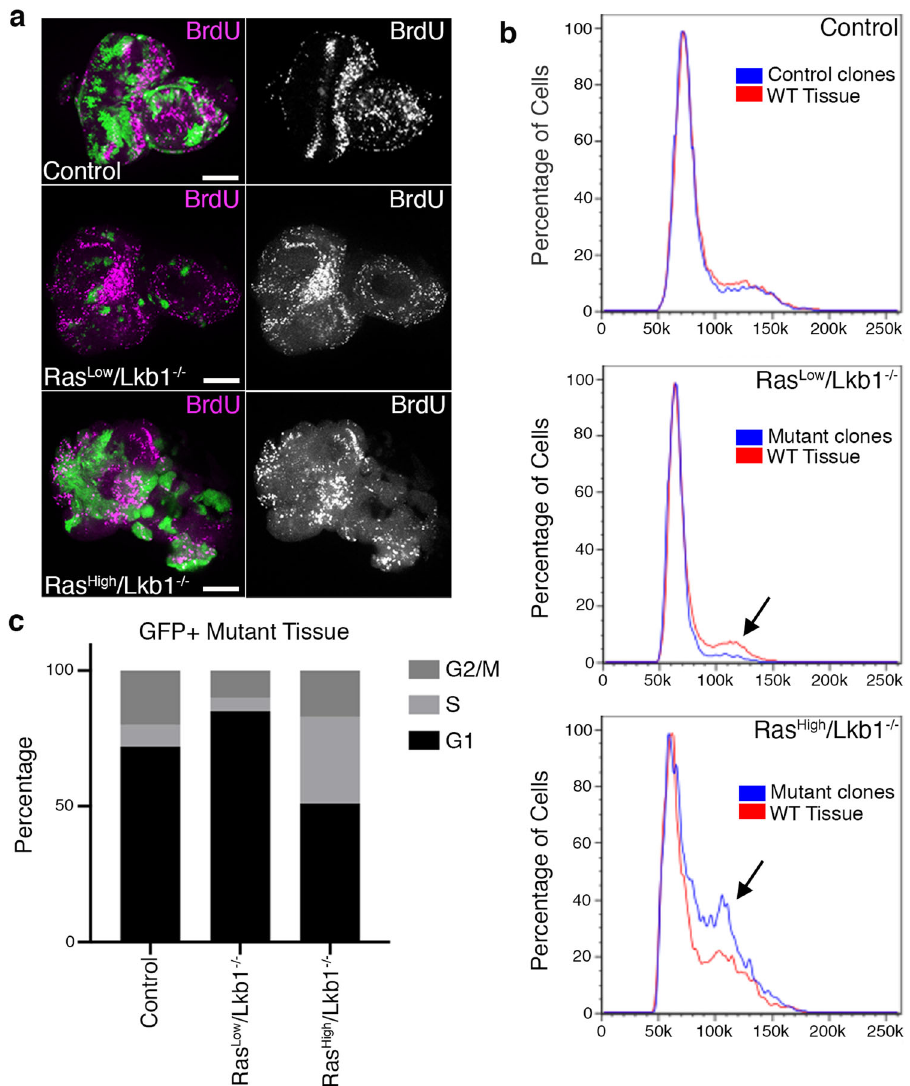
Fig. 2 The level of oncogenic Ras determines distinct autonomous vs. non-autonomous cell-cycle phenotypes in Lkb1 mutant tissue. a Confocal images of mosaic eye-imaginal discs carrying GFP + clones of the indicated genotypes (control = FRT82B ), and stained for BrdU incorporation (magenta). Images are representative of n = 10 independent eye-imaginal discs per genotype. Scale bar, 100 µ m. b Fluorescence-activated cell sorting (FACS) analysis of mosaic eye-imaginal discs with GFP-labeled clones of the indicated genotypes. Black arrows point to shifts in relative cell-cycle phasing. Analysis is representative of n = 3 independent experiments of 20 mutant imaginal discs/genotype and 40 imaginal discs/genotype for control. c Histogram showing percentage of GFP-labeled control or mutant cells in each phase of the cell